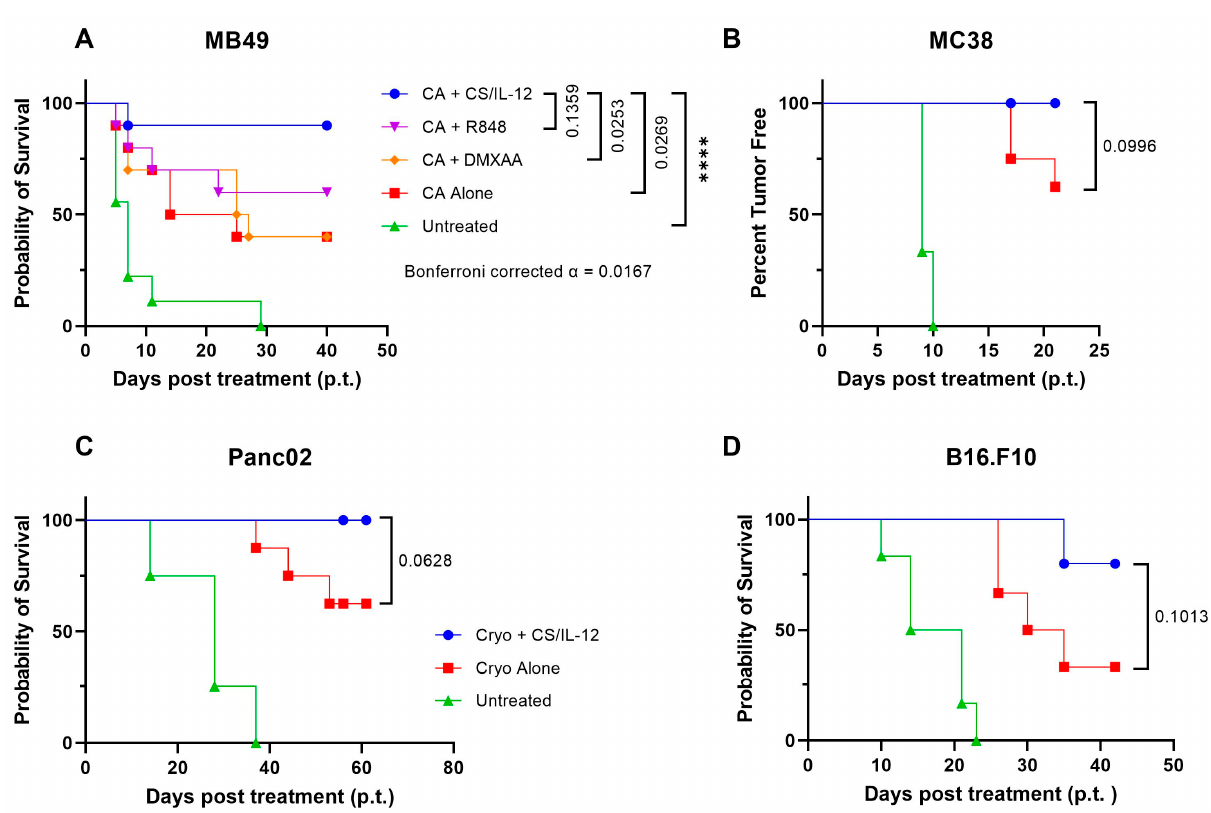
Figure 1. CS/IL-12 improves primary tumor elimination after CA in multiple models. ( A ) In the MB49 model (n = 10), mice were treated with CA and either a TLR7/8 agonist (R848), a STING agonist (DMXAA), or CS/IL-12 two days post CA. A table of p -values for the comparison of treatment groups using the Log-rank test is provided. In all other models (n = 8), including MC38 ( B ), Panc02 ( C ), and B16.F10 ( D ), CS/IL-12 was delivered intratumorally (i.t.) on the same day within an hour of CA. Tumor volume and survival was monitored and the threshold for euthanasia was 2000 mm 3